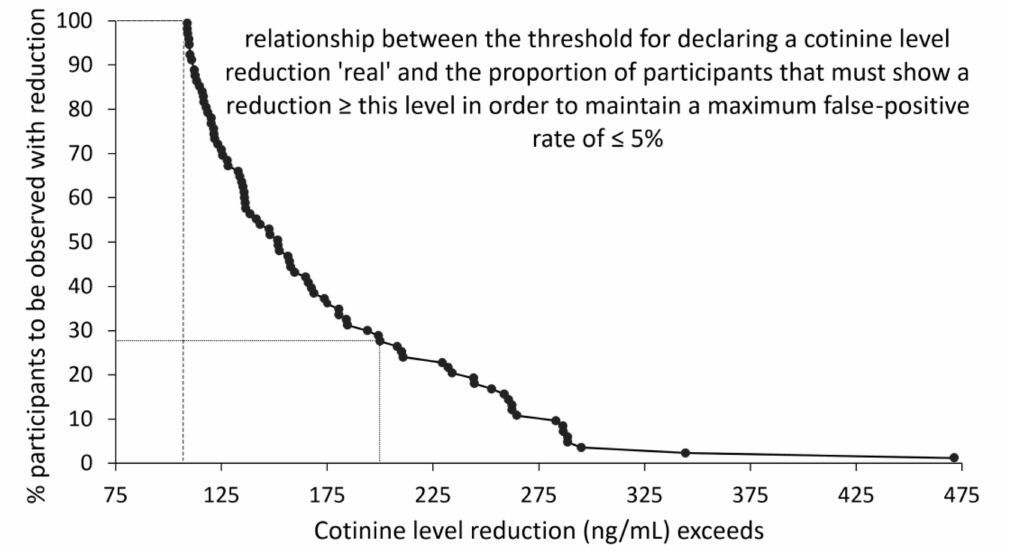
Figure 2. Determination of diagnostic threshold level for a maximum false-positive rate of 5% in a hypothetical smoking cessation study based on cotinine level reduction. The curve shows that only when all participants (100%) in such a study show a reduction in cotinine levels in excess of 108 ng / mL will the false-positive rate be 5% or less (dashed line). Similarly, if 28% or more of the participants show a reduction of 200 ng / mL or more, the false-positive rate will still be 5% or less (dotted